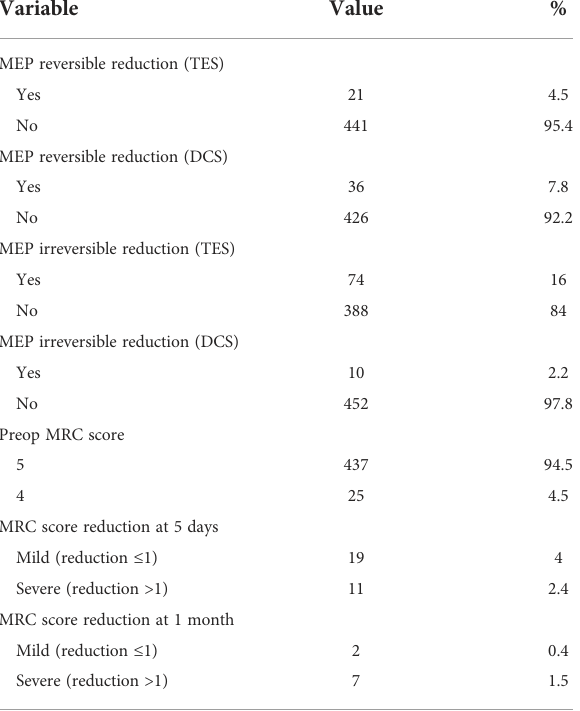
TABLE 2 Postoperative motor outcome and intraoperative fi